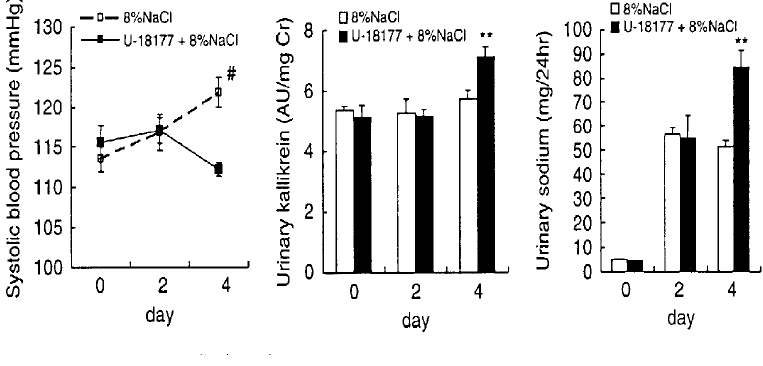
Figure 7. Effects of a kidney-selective ATP-sensitive potassium channel blocker (U-18177) on systolic blood pressure (left), urinary kallikrein levels (middle) and urinary sodium levels (right) in Sprague-Dawley strain SD rats fed on an 8% NaCl diet. U18177 (30 mg/kg twice a day) was given to rats on 8% NaCl diet (closed squares and columns). The values were compared with the values of rats given vehicle and 8% NaCl in their diet (open squares and columns). *P < 0.05, ** P < 0.01 vs . 8% NaCl in the diet on day 4 (reproduced from Ref.